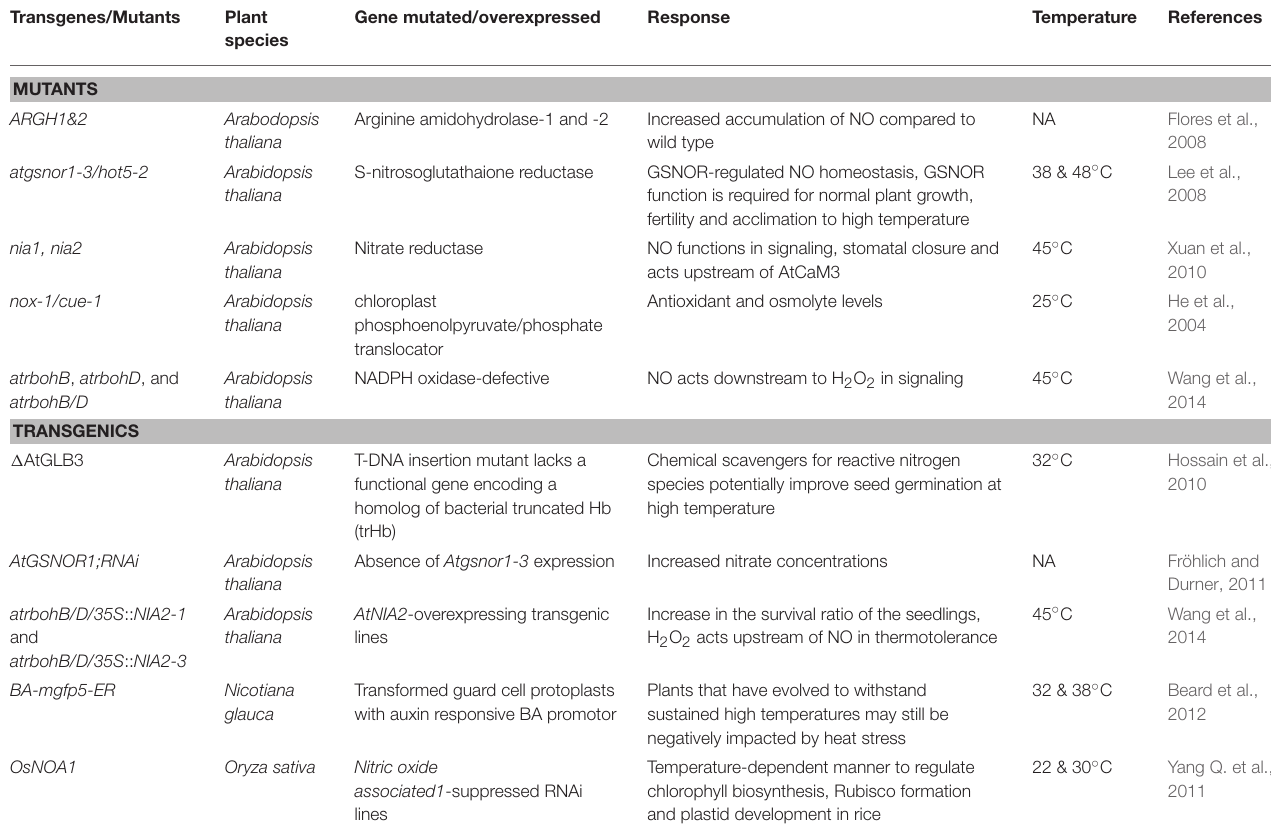
TABLE 3 | List of few mutants and transgenic lines used in elucidation of nitric oxide (NO) role in plant heat tolerance.